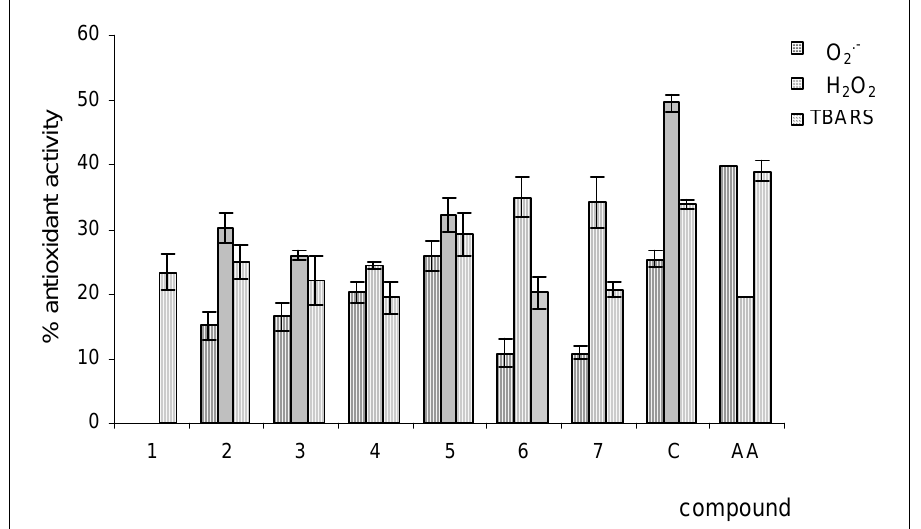
Figure 3 . Antioxidant activity of M. neapolitana Ten. flavones glycosides. C = catechin; AA = ascorbic